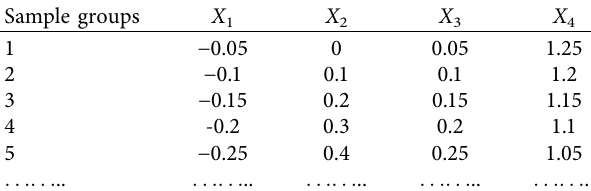
Table 6: Parameters in sample